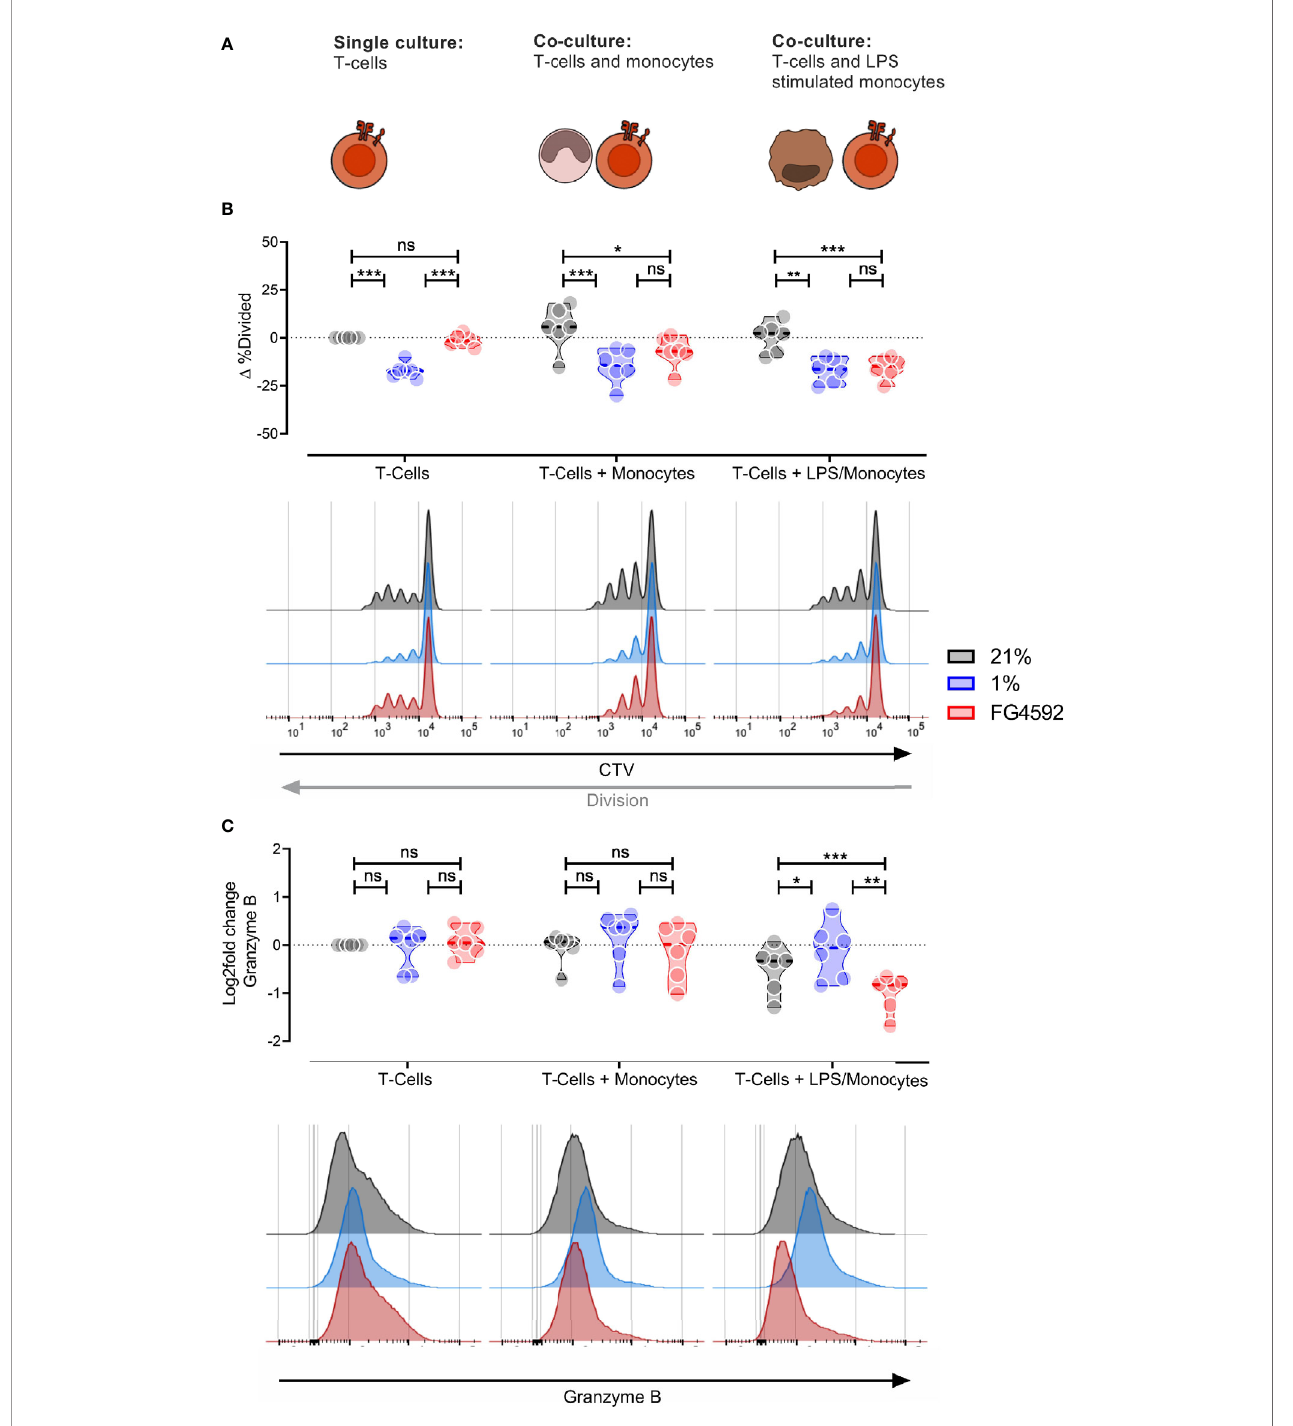
FIGURE 3 | Human monocyte compound induced HIF response blocks human T-cell division in vitro . (A) Illustration of the experimental layout. Human monocytes and CD8 + T-cells were isolated from peripheral blood mononuclear cells and activated with 100 ng/mL LPS and plate bound anti-CD3 antibodies (respectively) for 24 hours. Activation was followed by culturing activated CD8 + T-cells alone or co-culturing CD8 + T-cells with either unstimulated or LPS stimulated monocytes. (B) Percentage divided CD8 + T-Cells after three days in three different culturing conditions and treatments; DMSO, 1% O 2 or 12.5 µM. All samples presented as the difference to untreated single cultured donor-matched CD8 + T-cells. (C) Expression of Granzyme B in CD8 + T-cells treated as in (B) . Data is log 2 fold change MFI relative to untreated single cultured donor-matched CD8 + T-cells. Data presented as violin plots or representative histograms, *P < 0.05, **P < 0.01, ***P < 0.001; ns, not signi fi cant. Statistical analysis was performed with Two-way RM ANOVA and Tukey ’ s multiple comparisons test, n = 6 blood